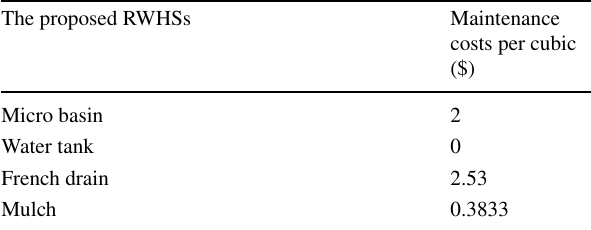
Table 7 Maintenance cost of the proposed RWHSs The proposed